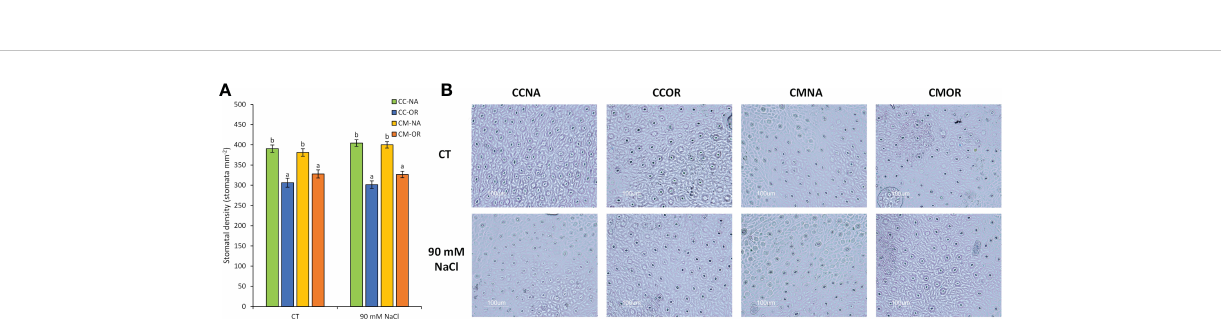
FIGURE 4 Stomata-related parameters. (A) Stomatal density in leaves of CC-NA (green bars), CC-OR (blue bars), CM-NA (yellow bars), and CM-OR (orange bars) control and salt-stressed plants. (B) Microscope photographs from stomata preparations from leaves of control and salt-stressed plants after 30 days. Values are the mean of 20 leaves ± standard error. Different letters denote statistically signi fi cant differences among the rootstock/scion combinations for each treatment at p ≤ 0.05.